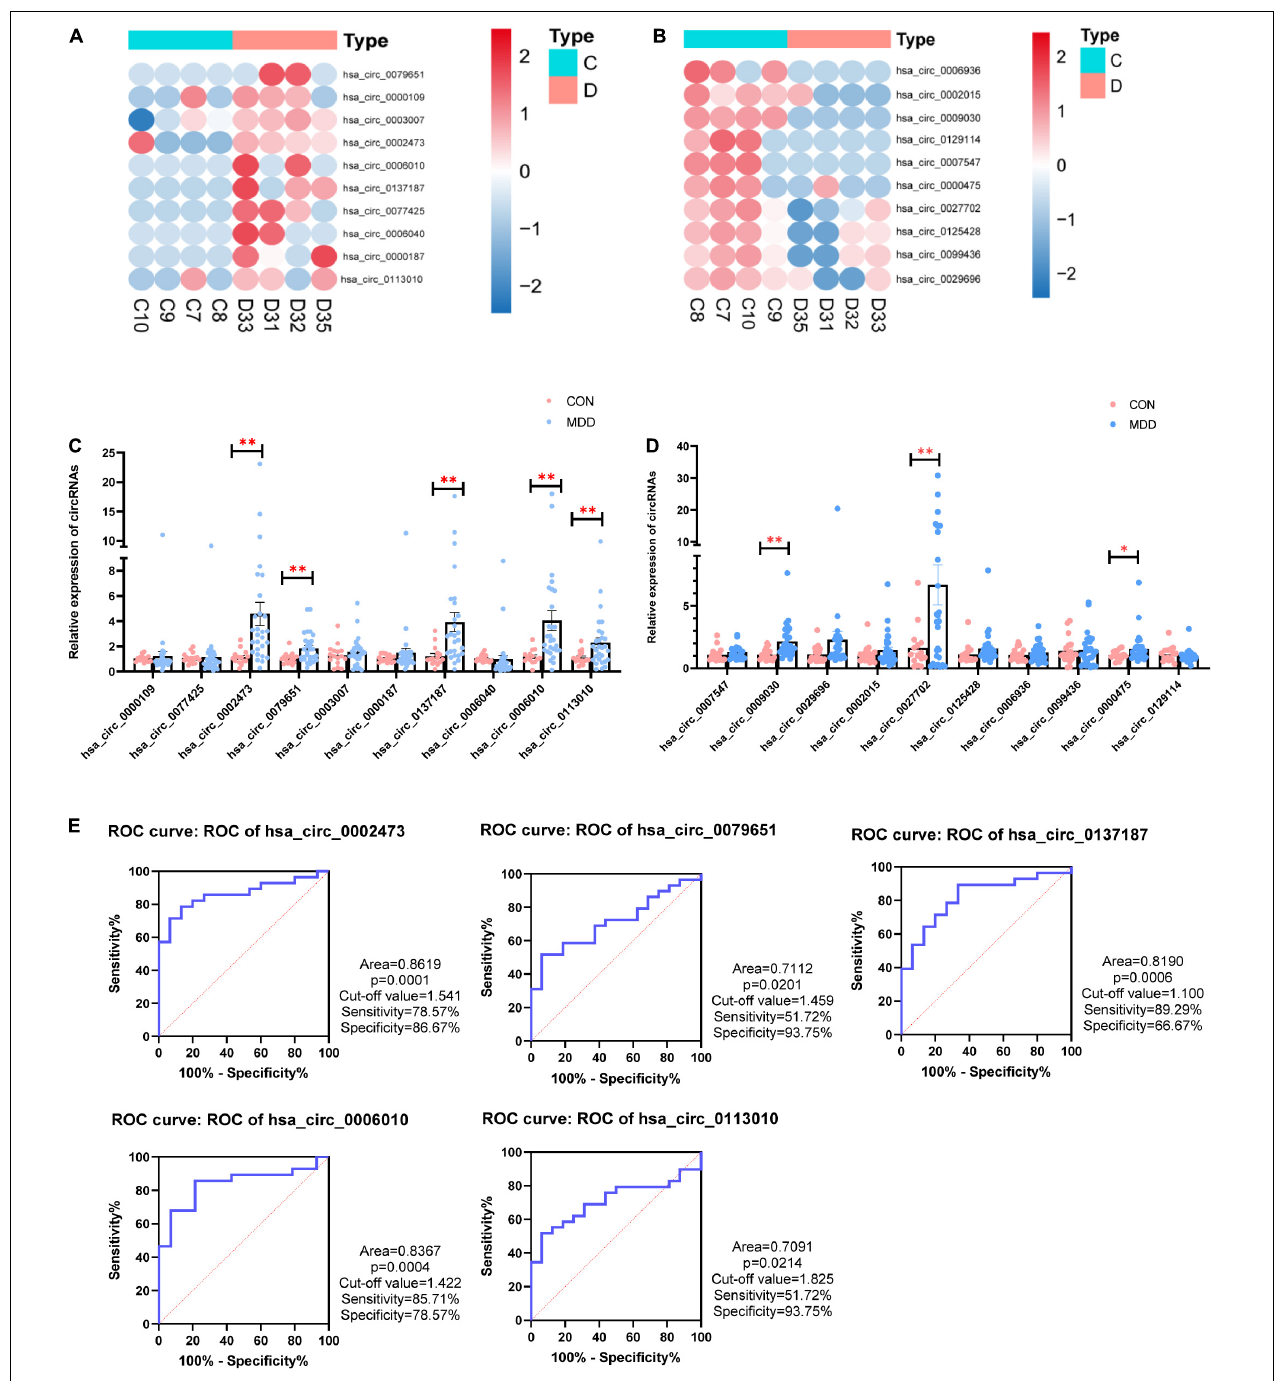
FIGURE 2 | 20 candidate CircRNAs (top 10 upregulated and top 10 downregulated) in MDD patients and healthy controls. (A) Heatmaps of top 10 upregulated circRNAs. (B) Heatmaps of top 10 downregulated circRNAs. (C) Comparison of top 10 upregulated circRNAs relative expressions between 29 MDD patients and 19 healthy controls. (D) Comparison of top 10 downregulated circRNAs relative expressions between 29 MDD patients and 19 healthy controls. (E) ROC curve analyses of 5 verified candidate circRNAs for predicting MDD risk. Data are presented as mean ± standard error of the mean (SEM). ∗ p < 0.05, ∗∗ p <